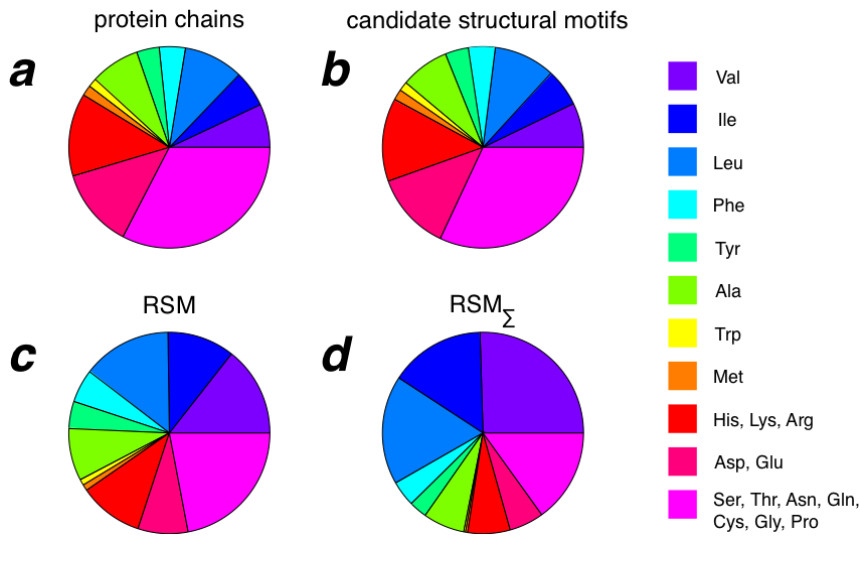
Figure 4. Amino acid compositions as seen over all residues in ( a ) all chains, ( b ) all candidate structural motifs and ( c ) all RSMs. In the case of ( d ), amino acid composition has been summed overall RSMs, counting each residue as many times as it is present in